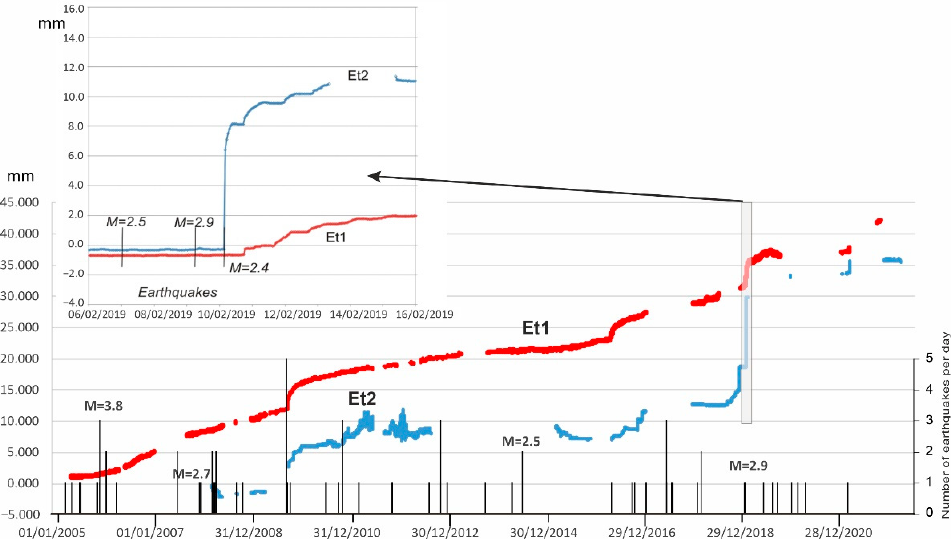
Figure 9. Extensometers data recorded at Et1 and Et2 stations (2005–2021). Daily earthquake occurrence from Figure 6. In the inset, the signals recorded during 6–16 February 2019 and timing of the earthquakes.